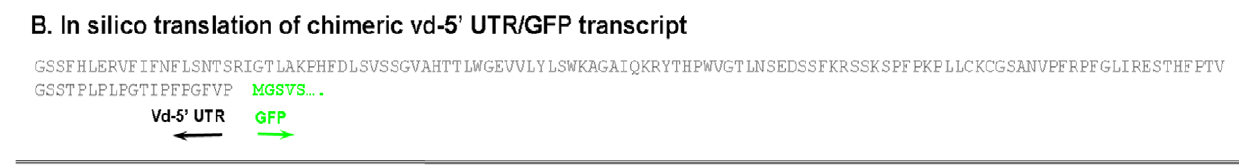
Figure 2. Details of the fusion ELVd-derived RNA/GFP mRNA. ( A ) Partial DNA sequence of the vd-5 9 UTR-GFP construct (AN - HM136583) used in this study. ( B ) In silico predicted translation of the vd-5 9 UTR-GFP transcript.